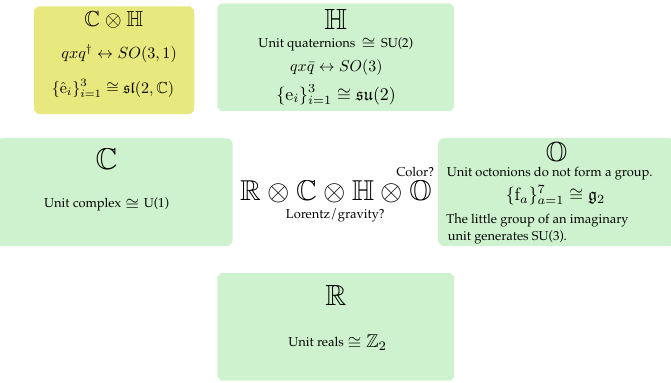
Figure 1. In this diagram, we summarise the relations of the different algebras with physically relevant groups as explained in the main